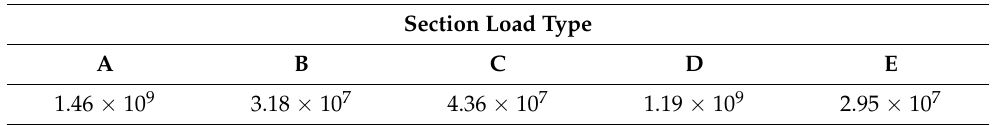
Table 9. Ultimate bearing capacity of the control section internal force of the local connection node of the object